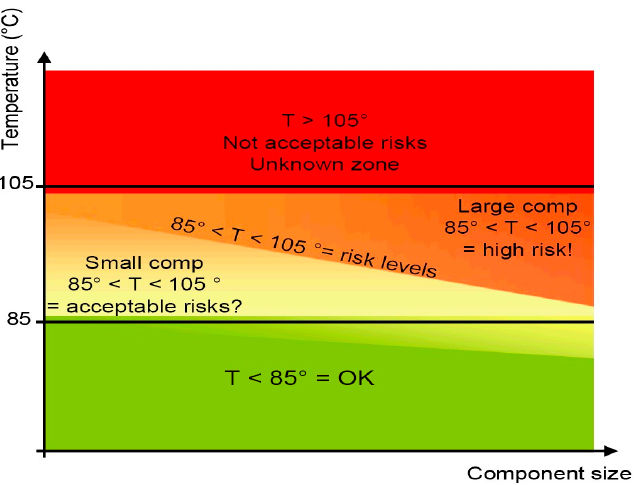
Figure 17. Influence of temperature on the lifetime of a soldered joint depending on the size of the soldered component.